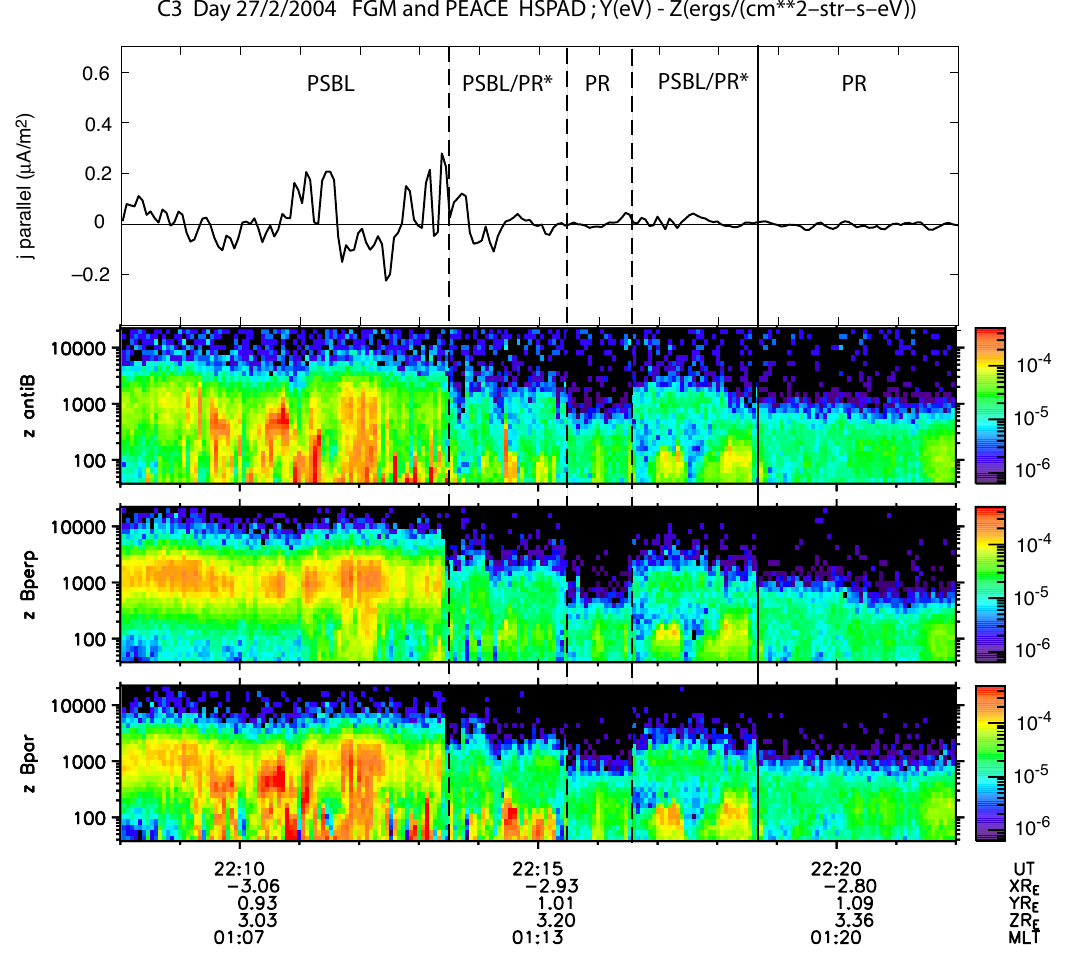
Fig. 11. Downward FAC for C3 (top panel) and PEACE data in the same format as Fig. 6 (bottom